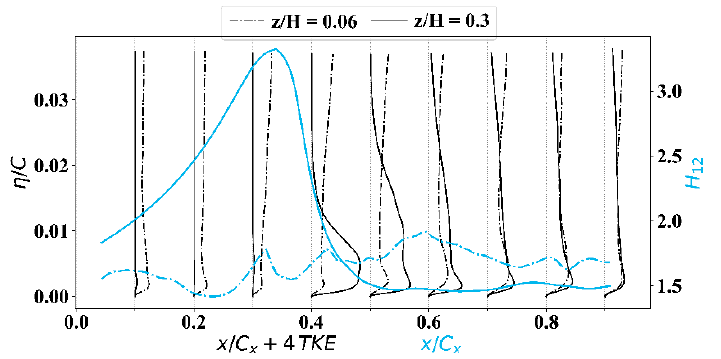
Figure 13. Blade suction side boundary layer state, characterized through the turbulent kinetic energy (TKE) in normal direction to the blade ( η /C) and the shape factor (H 12 ). The departure of the TLV results in the secondary flow influencing almost the entire pitch at the outlet plane (Figure 14), with its core located approximately at the middle of the passage pitch. The wiggly isosurfaces in Figure 11 hint towards the increased levels of turbulent fluctuations around the TLV and away from the blade.